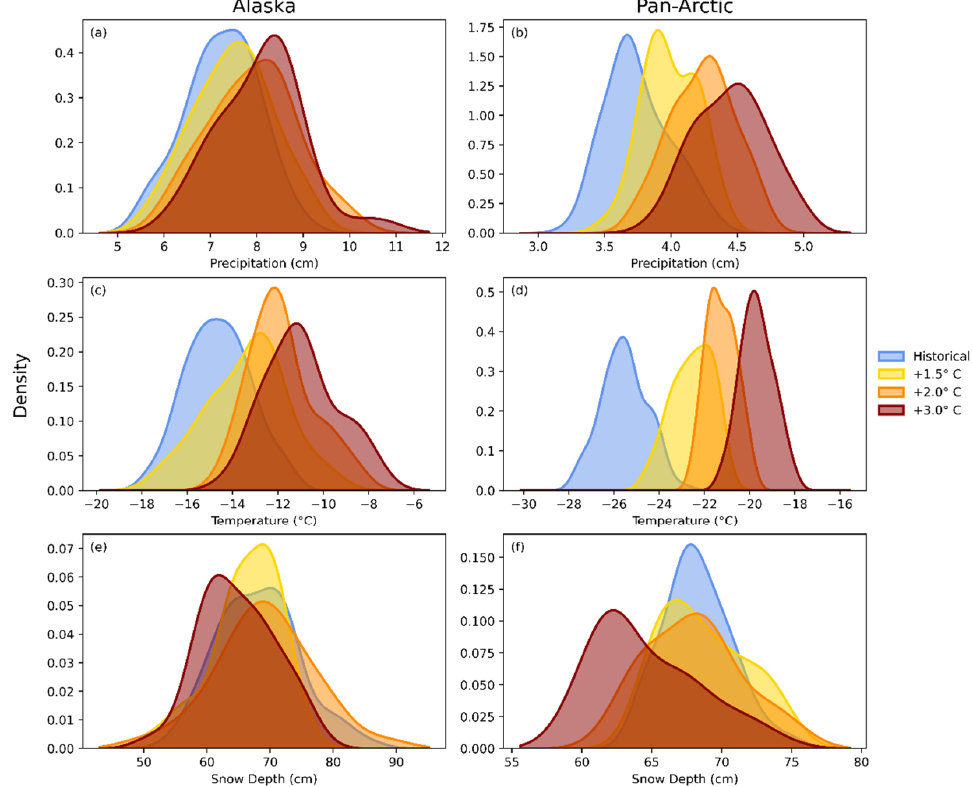
Figure 8. Probability density functions for Alaska (left column) and pan-Arctic (right column) winter precipitation ( a , b ), temperature ( c , d ) and snow depth ( e , f ). Distributions for historical simulations are shown in blue, and distributions for 1.0 °C, 2.0 °C and 3.0 °C global warming are shown in yellow, orange and brown, respectively.